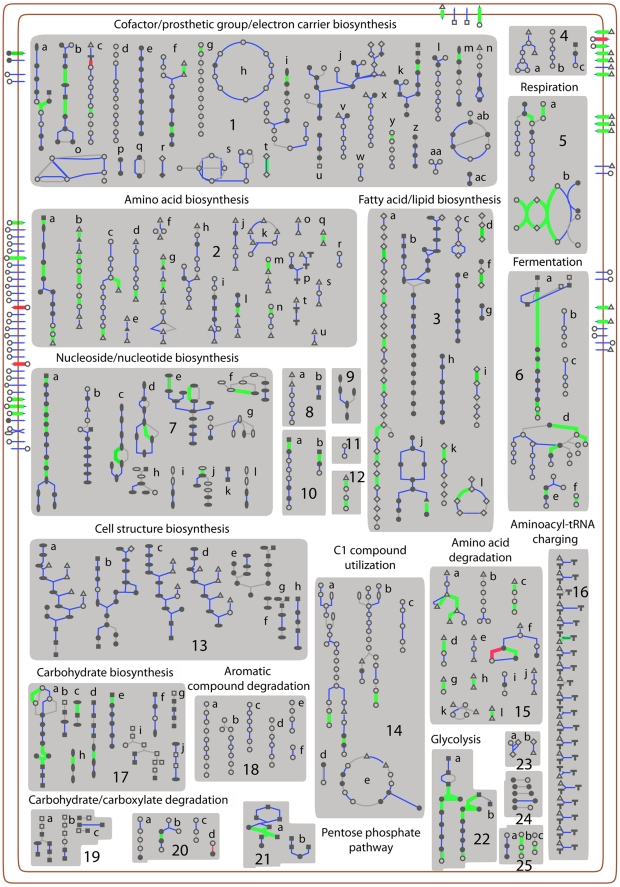
Cellular overview of C. jejuni metabolic pathways.Metabolic pathways are grouped into different general functional categories as indicated. Protein transporters are located at the double peripheral lines representing the bacterial membrane structure. Within individual pathways, symbols represent metabolites and connecting lines denote respective enzymes that catalyze the inter-conversion of those metabolites. Most enzymes are color-coded in the following fashion: blue indicates mapped proteins in pathways present in the C. jejuni proteome, grey indicates those not found in the annotated genome, bold green represents those proteins whose expression levels were lower at 20 h of infection relative to 2 h of infection, and bold red corresponds to up-regulated proteins at 20 h of infection. Description of individually numbered pathways is as follows: 1. a, flavin biosynthesis; b, methylerythritol phosphate pathway; c, tetrapyrrole biosynthesis; d, ubiquinone-8 biosynthesis; e, di-trans, poly-cis-undecaprenyl phosphate biosynthesis; f, pantothenate biosynthesis I; g, chlorophyllide a biosynthesis I; h, TCA cycle; i, tetrahydrofolate biosynthesis; j, thiamine biosynthesis I; k, pyridoxal 5′-phosphate biosynthesis; l, coenzyme M biosynthesis; m, 6-hydroxymethyl-dihydropterin diphosphate biosynthesis; n, NAD biosynthesis I; o, folate transformations p. phosphate acquisition I; q, NAD phosphorylation and dephosphorylation; r, acyl carrier protein metabolism; s, formyl THF biosynthesis I; t, thioredoxin pathway; u, NAD salvage pathway II; v, biotin biosynthesis; w, menaquinone-8 biosynthesis; x, biotin biosynthesis; y, heme biosynthesis from uroporphyrinogen-III II; z, trans, trans-farnesyl diphosphate biosynthesis; aa, glutathionylspermidine biosynthesis; ab, NAD salvage pathway I; ac, geranyldiphosphate biosynthesis. 2. a, histidine biosynthesis; b, lysine biosynthesis I; c, valine biosynthesis; d, isoleucine biosynthesis I; e, threonine biosynthesis from homoserine; f, homocysteine biosynthesis; g, homoserine biosynthesis; h, ornithine biosynthesis; i, tryptophan biosynthesis; j, proline biosynthesis I; k, S-adenosyl-L-methionine cycle I; l, serine biosynthesis; m, alanine biosynthesis; n, tyrosine biosynthesis I; o, alanine biosynthesis III; p, selenocysteine biosynthesis I; q, glutamate biosynthesis; r, protein citrullination; s, cysteine biosynthesis I; t, L-glutamine biosynthesis II; u, glutamine biosynthesis I; 3. a, palmitate biosynthesis II; b, CMP-KDO biosynthesis I; c, biotin-carboxyl carrier protein assembly; d, fatty acid biosynthesis initiation III; e, CDP-diacylglycerol biosynthesis I; f, fatty acid biosynthesis initiation II; g, cyclopropane fatty acid (CFA) biosynthesis; h, CDP-diacylglycerol biosynthesis II; i, cis-vaccenate biosynthesis; j, phospholipid biosynthesis I; k, stearate biosynthesis II; l, fatty acid elongation-saturated. 4. a, (5R)-carbapenem biosynthesis; b, hyperforin biosynthesis; c, myo-inositol biosynthesis. 5. a, respiration (anaerobic); b, aerobic respiration-electron donor II. 6. a. homolactic fermentation; b. (S)-acetoin biosynthesis; c. (R)-acetoin biosynthesis I d. mixed acid fermentation; e. pyruvate fermentation to acetate; f. pyruvate fermentation to lactate. 7. a, 5-aminoimidazole ribonucleotide biosynthesis I; b, uridine-5′-phosphate biosynthesis c, adenosine nucleotides de novo biosynthesis; d, guanosine nucleotides de novo biosynthesis; e, pyrimidine deoxyribonucleotides de novo biosynthesis; f, salvage pathways of pyrimidine ribonucleotides; g, salvage pathways of guanine, xanthine, and their nucleosides; h, salvage pathways of purine and pyrimidine nucleotides; i, salvage pathways of purine and pyrimidine nucleotides; j, salvage pathways of purine and pyrimidine nucleotides; k, salvage pathways of purine and pyrimidine nucleotides; l, salvage pathways of purine and pyrimidine nucleotides. 8. a, autoinducer AI-2 biosynthesis I; b, PRPP biosynthesis I. 9. ppGpp biosynthesis. 10. a, chorismate biosynthesis I; b, 3-dehydroquinate biosynthesis I. 11. IAA biosynthesis V. 12. putrescine biosynthesis II. 13. a, UDP-N-acetylmuramoyl-pentapeptide biosynthesis I (generic); b, superpathway of KDO2-lipid A biosynthesis; c, peptidoglycan biosynthesis III; d, UDP-N-acetylmuramoyl-pentapeptide biosynthesis III (meso-DAP); e, enterobacterial common antigen biosynthesis; f, O-antigen biosynthesis; g, dTDP-L-rhamnose biosynthesis I; h, UDP-N-acetyl-D-glucosamine biosynthesis I. 14. a, purine degradation II (anaerobic); b, purine degradation III (anaerobic); c, formaldehyde oxidation V (tetrahydrofolate pathway); d, reductive monocarboxylic acid cycle; e, formaldehyde assimilation I (serine pathway). 15. a, aspartate-glutamate-proline degradation; b, tyrosine degradation I; c, arginine degradation IV; d, aspartate degradation II; e, proline degradation II; f, L-serine degradation; g, lysine degradation I; h, glutamine degradation II; i, citrulline degradation; j, proline degradation I; k, phenylalanine degradation (aerobic); l, asparagine degradation I. 16. tRNA charging pathway. 17. a, gluconeogenesis I; b, colanic acid building blocks biosynthesis; c, colanic acid building blocks biosynthesis; d, GDP-mannose biosynthesis; e, ADP-L-glycero-beta-D-manno-heptose biosynthesis; f, CMP-KDO biosynthesis II; g, GDP-glucose biosynthesis; h, GDP-D-rhamnose biosynthesis; i, glycogen degradation I; j, CMP-N-acetylneuraminate biosynthesis II. 18. a, protocatechuate degradation I; b, methylgallate degradation; c, protocatechuate degradation III; d, orthanilate degradation; e, cyanurate degradation; f, anthranilate degradation I (aerobic). 19. a, galactose degradation I; b, glycogen degradation II; c, glucose and glucose-1 phosphate degradation. 20. a, glycolate and glyoxylate degradation I; b, pyruvate fermentation to acetate VII; c, glycolate and glyoxylate degradation II; d, acetate conversion to acetyl-CoA. 21. a, pentose phosphate pathway (non-oxidative branch); b, pentose phosphate pathway (partial). 22. a, glycolysis I b. glycolysis II. 23. a, seed germination protein turnover; b, wound-induced proteolysis I. 24. fatty acid and lipids degradation. 25. a, sulfate activation for sulfonation, b, nitrate reduction III; c, nitrate reduction IV. Open triangles: Amino acids; open squares: carbohydrates; open rhomboids: proteins; vertical ovals: purines; horizontal ovals: pyrimidines; inverted triangles: cofactors; T:tRNAs; open circles: other; closed symbols indicate phosphorylated forms. (Note: this data has been deposited in the BioCyc home page [
http://biocyc.org/
] where it can be seen in an interactive fashion).